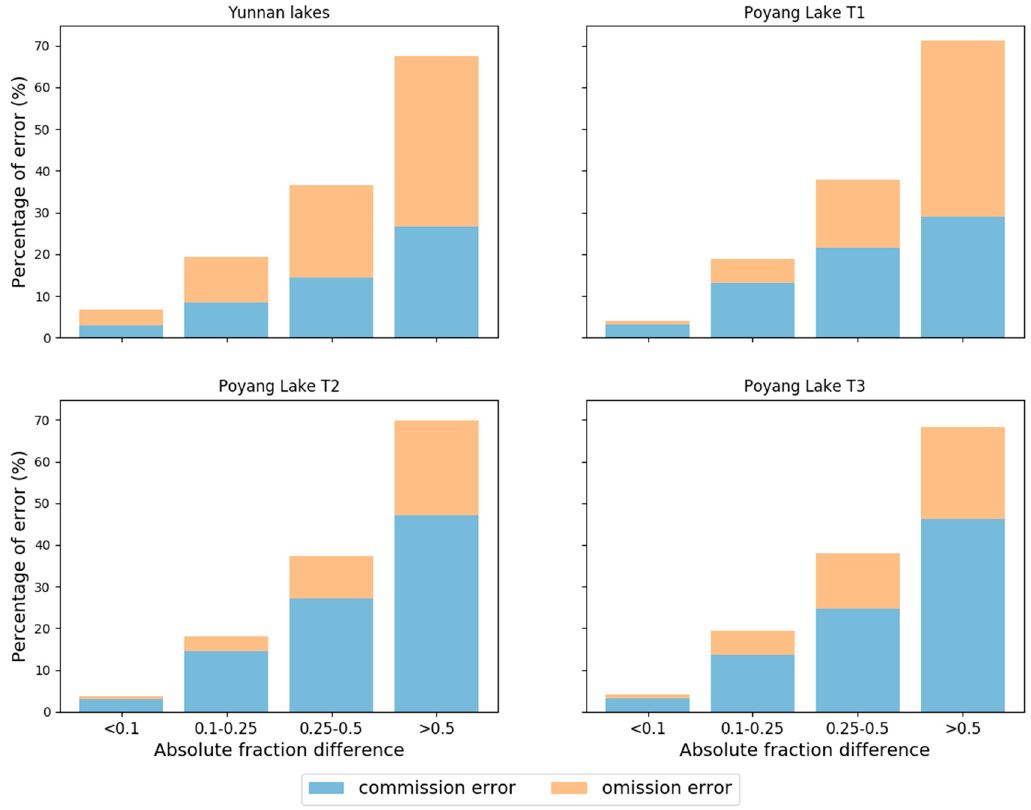
Figure 9. Commission and omission errors of subpixel mapping of mixed pixels with different levels of absolute difference.